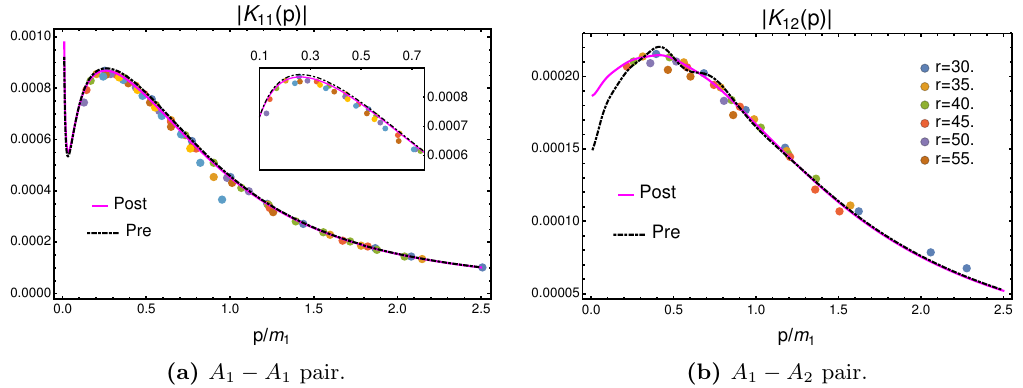
Figure 6 . Predictions of the two perturbative expansions against the TCSA data for the two-particle overlaps K 11 and K 12 as functions of the dimensionless momentum p/m 1 after a quench of size ξ = 0 . 05 in volume (a) m 1 R = 30 . . . 65 and (b) m 1 R = 30 . . . 55 . The two expansions almost completely agree. The inset illustrates that the post-quench expansion is slightly closer to TCSA